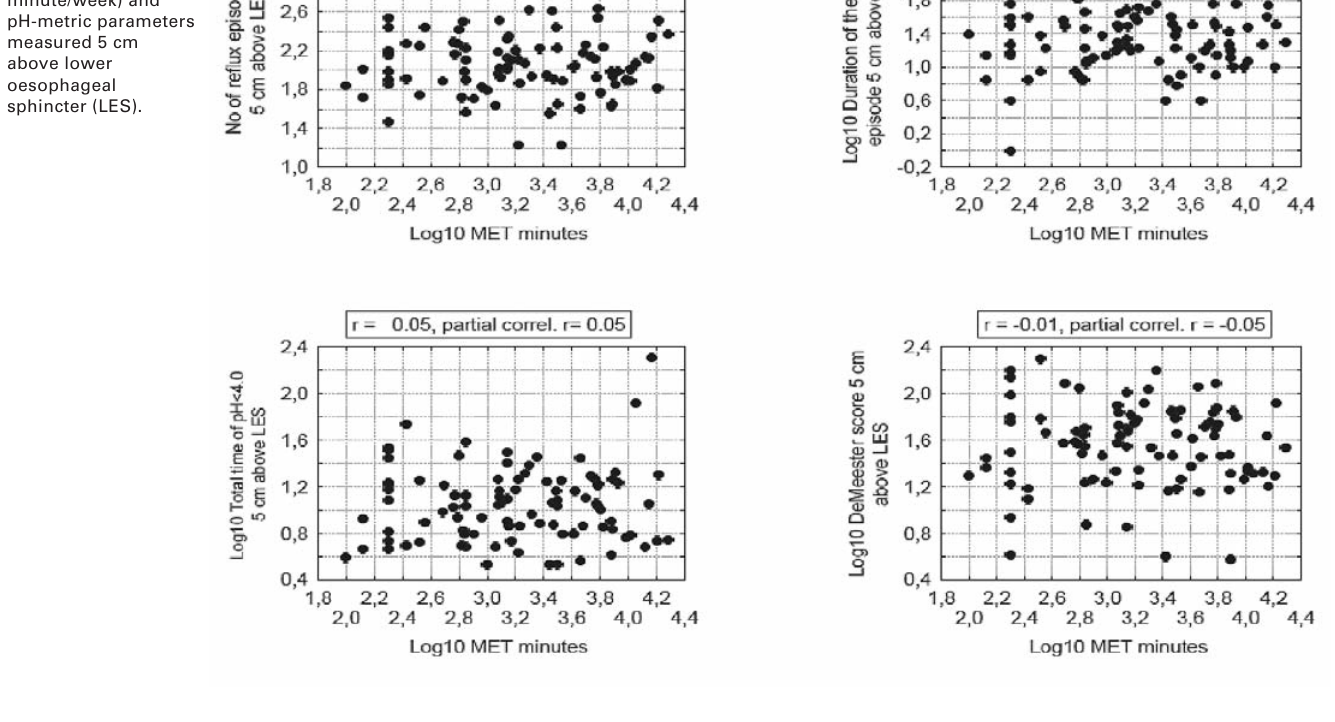
Correlations between the level of physical activity (METs- minute/week) and pH-metric parameters measured 5 cm above lower oe- sophageal sphincter (LES).